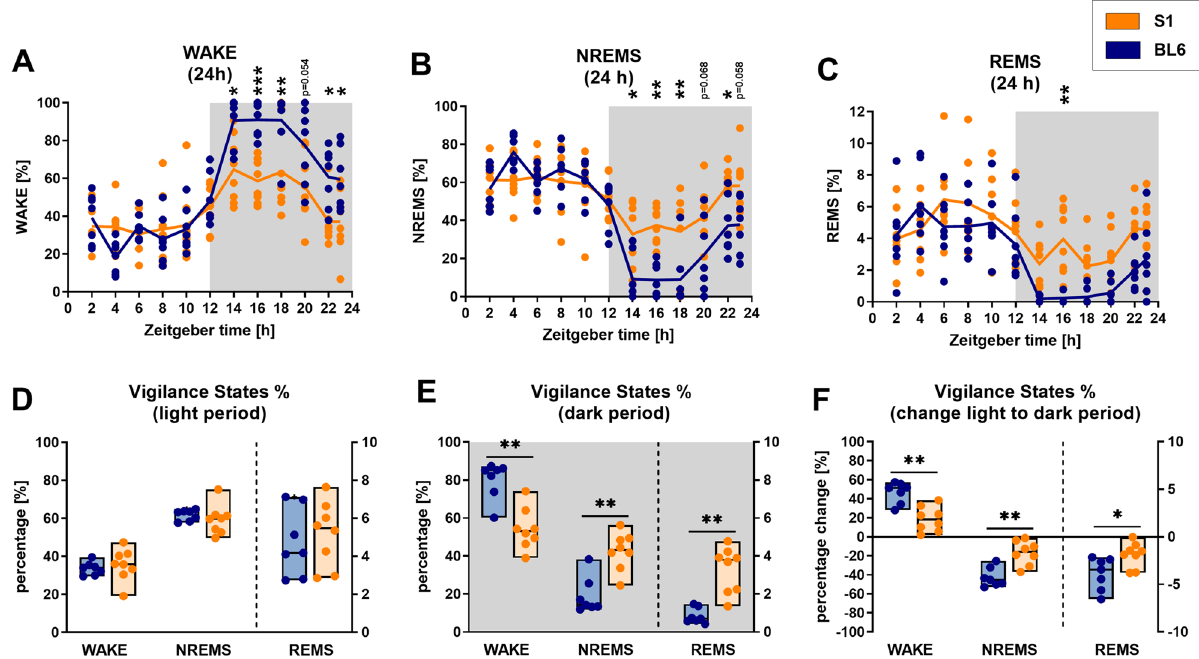
Figure 2. Circadian sleep/wake behavior of S1 (n = 8) compared to BL6 (n = 7) mice. The circadian time courses of all vigilance states differed between S1 and BL6 mice [( A ) WAKE: ‘strain’: p = 0.002, ‘time’: p < 0.001, ‘time x strain interaction’: p < 0.001; ( B ) NREMS: ‘strain’: p = 0.003, ‘time’: p < 0.001, ‘time x strain interaction’: p < 0.001; ( C ) REMS: ‘strain’: p = 0.040, ‘time’: p < 0.001, time x strain interaction: p = 0.003]. In the light period ( D ), 12-h average percentages of all vigilance states were similar in S1 and BL6 mice (WAKE: p = 0.281; NREMS: p = 0.232; REMS: p = 0.463). Differences were mainly confined to the dark period ( E ), where S1 mice spent more time in NREMS (p = 0.002) and REMS (p = 0.001), while the percentage of WAKE (p = 0.002) was decreased. The diurnal change in the percentage of sleep and wakefulness from light to dark period ( F ) was less pronounced in S1 than BL6 animals (WAKE: p = 0.002; NREMS: p = 0.002; REMS: p = 0.021). ( A – C ) All graphs show 2 h means and individual data points, white and grey backgrounds indicate light and dark period. Statistical significance was determined by two-way RM ANOVA with one-factor repetition (Sidak post-hoc test). ( D – F ) All floating bars show min-to-max values with median and individual data points. Statistical significance was determined with a Mann–Whitney U test (*p < 0.05, **p <